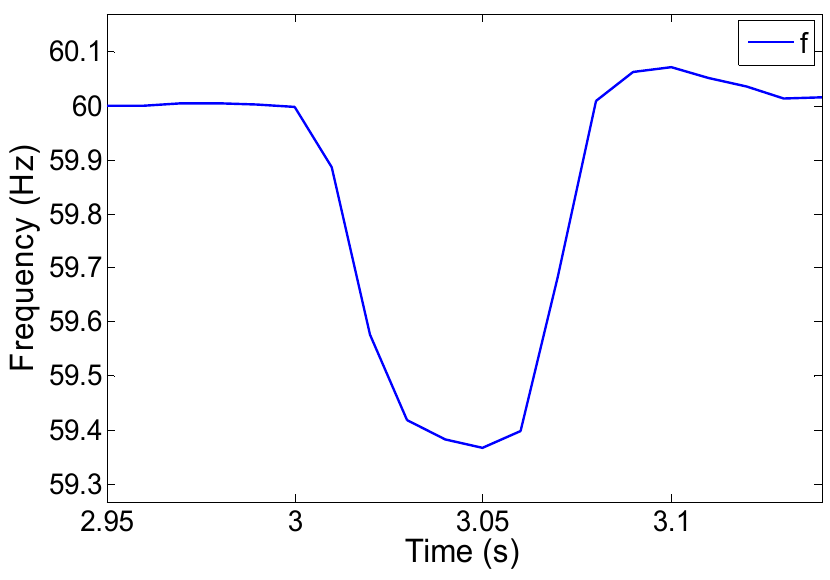
Figure 16. DC active power flow in the first case.